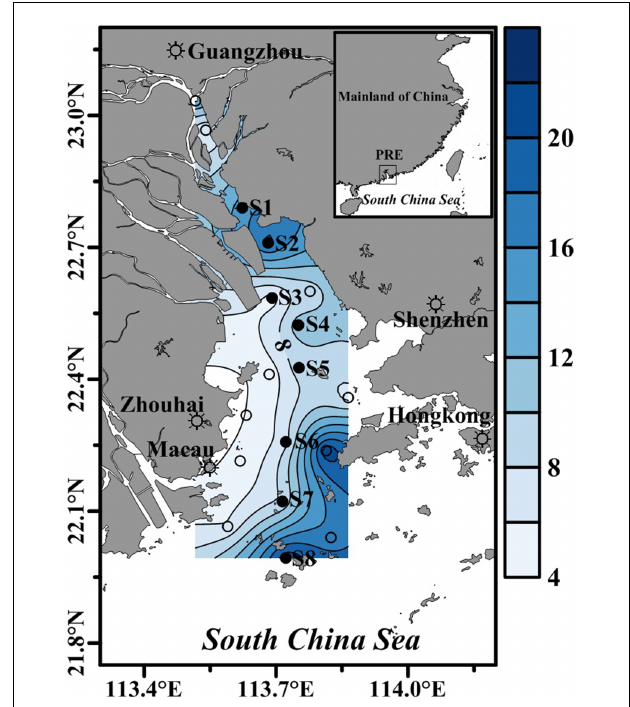
FIGURE 1 | The location of sampling stations in the Pearl River Estuary during the two cruises. Bacterial metabolic rates, nutrients and Chl a concentrations were determined at stations denoted by solid circles, while water temperature and salinity were determined at all stations. The contour shows water depth.